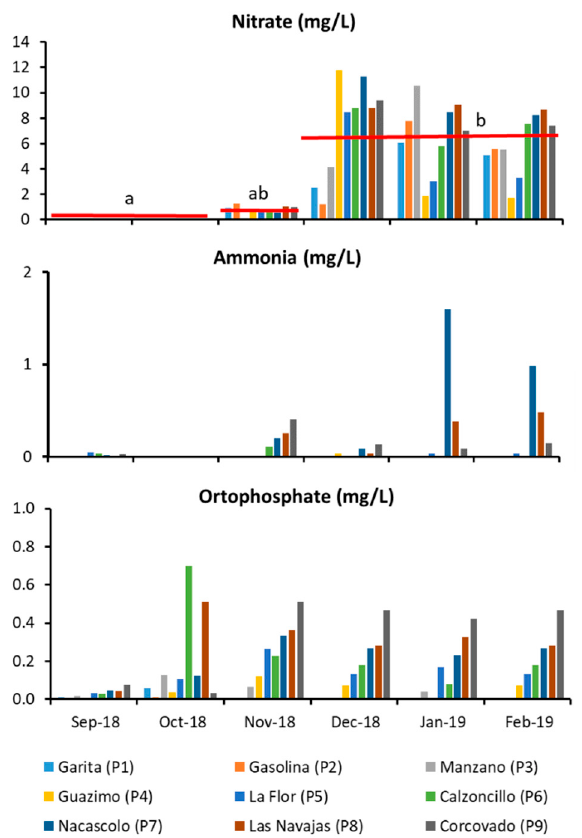
Figure 8. Nutrient concentrations measured in the nine sites of the Estero Salinas Grandes. Red bars show the mean of each different group based on ANOVA results (Table S2; Supplementary material). The lower-case letters indicate significant differences in pairwise comparisons. Significant values when p < 0.001.